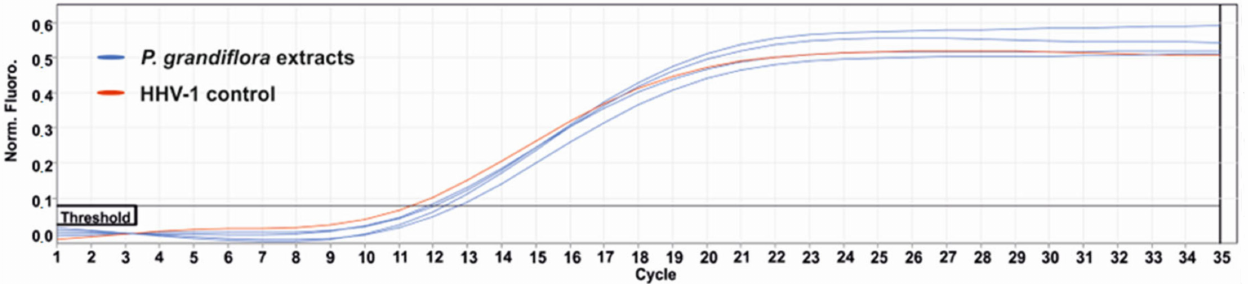
Figure 7. The qPCR amplification curves used for the measurement of HHV-1 viral